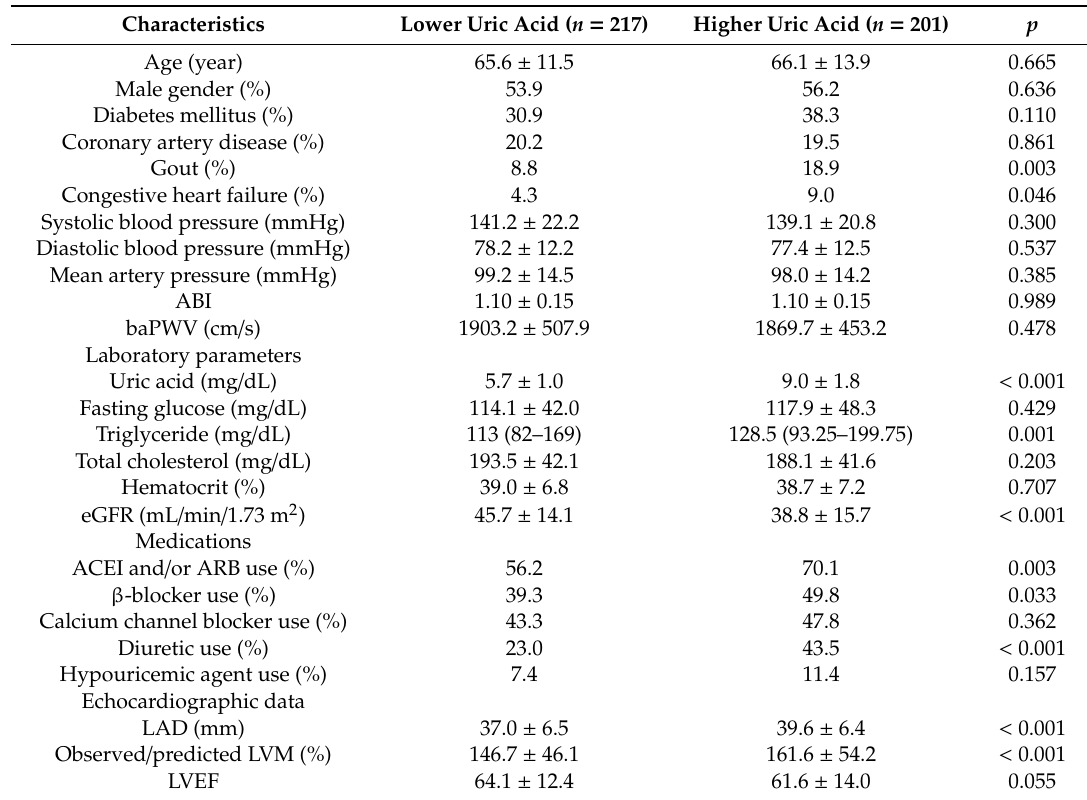
Table 1. Comparison of baseline and echocardiographic characteristics between patients with lower and high uric acid levels.